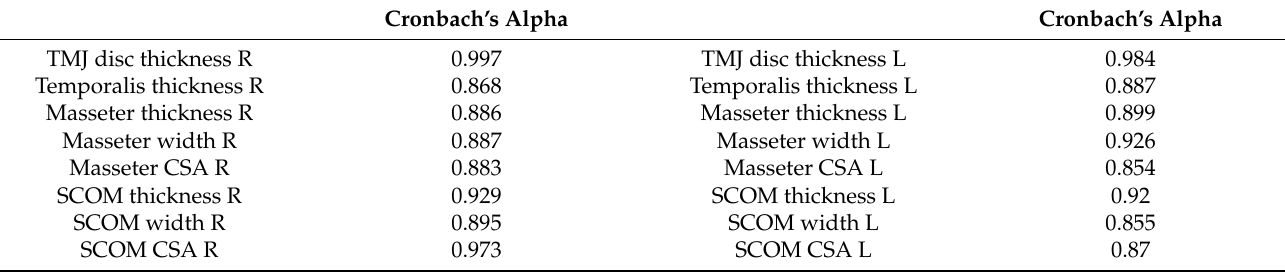
Table 5. Inter-operator reliability data with Cronbach’s alpha